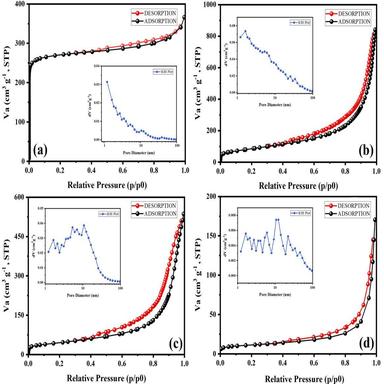
N2 adsorption and desorption isotherms (BET) and BJH plots (inset) of a) Al-Fum MOF b) NiAl-LDH, c) CoAl-LDH and d) ZnAl-LDH.